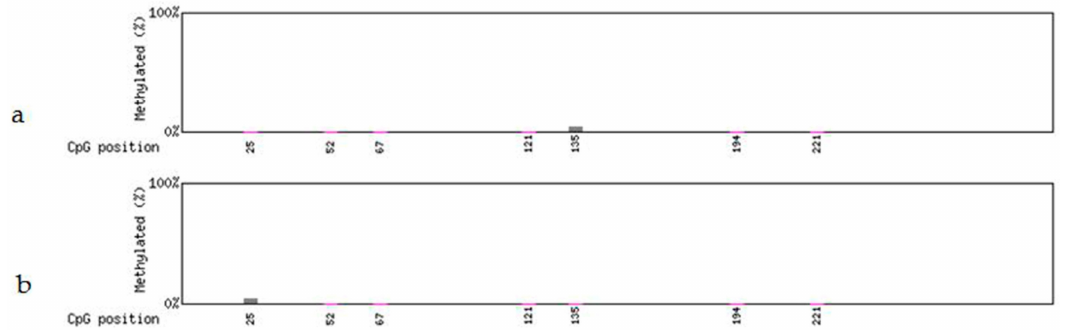
Figure 7. Methylation levels in the partial FLP gene sequence after heat-shock treatment. ( a ) Non-deletion